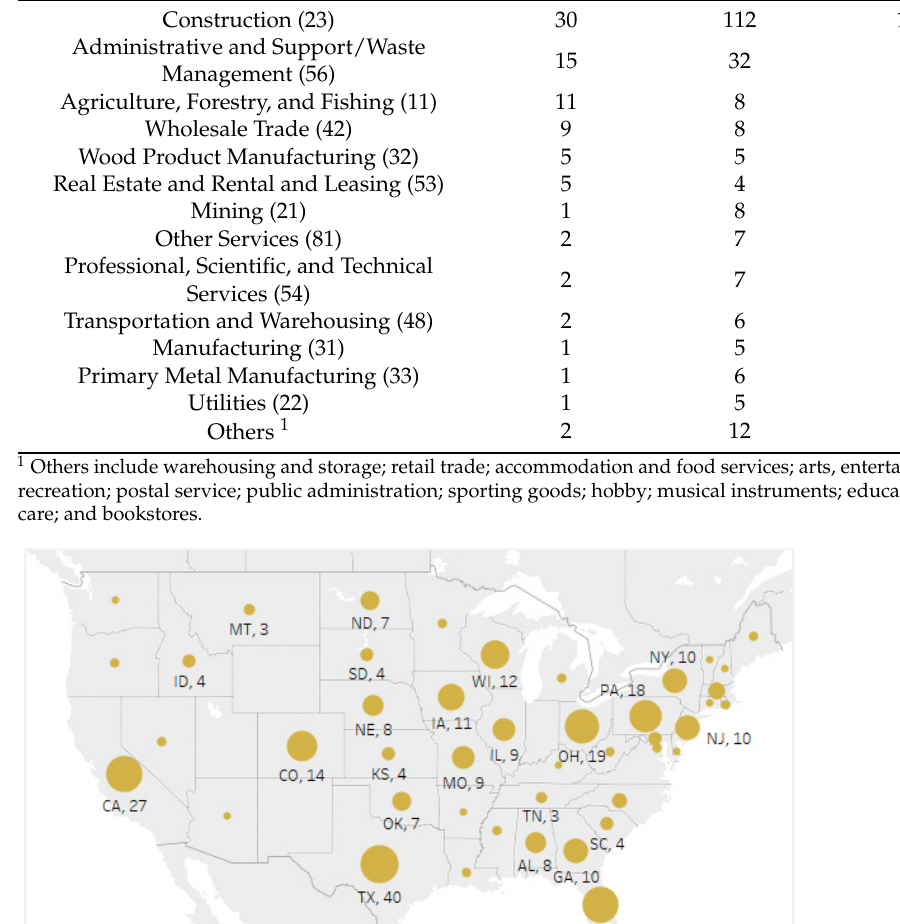
Table 1. Industrial sectors and numbers of fatal and nonfatal injuries.